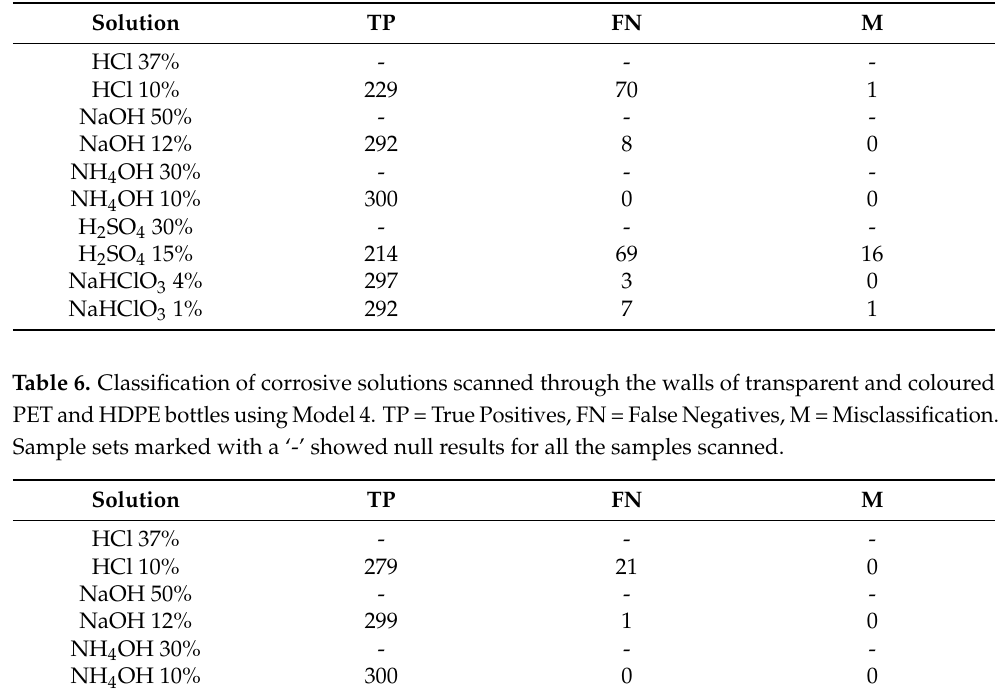
Table 5. Classification of corrosive solutions scanned through the walls of transparent and coloured PET and HDPE bottles using Model 3. TP = True Positives, FN = False Negatives, M = Misclassification. Sample sets marked with a ‘-’ showed null results for all the samples scanned.